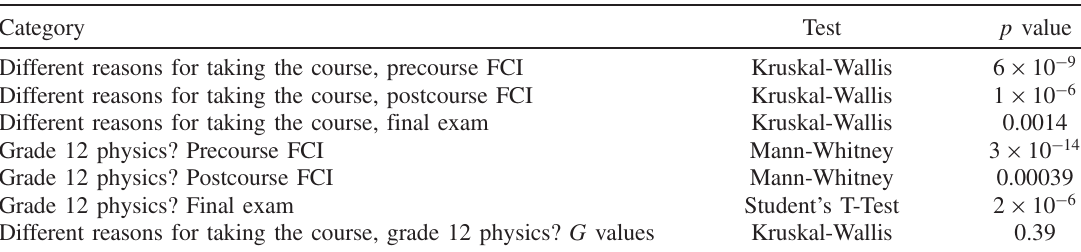
TABLE VII. p values for different categories of